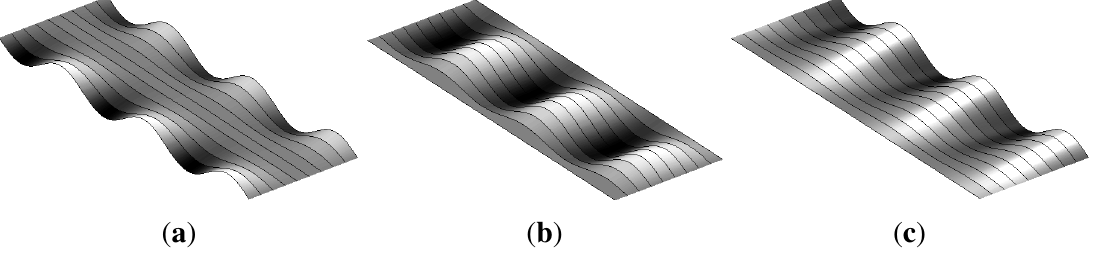
Figure 3. Common flatness defects of steel, flat-rolled products: ( a ) wavy edges (fibers at the edges are longer than fibers at the center); ( b ) center buckle (fibers at the center are longer than fibers at the edges); ( c ) bad leveling (the length of the fibers increase from one edge to the